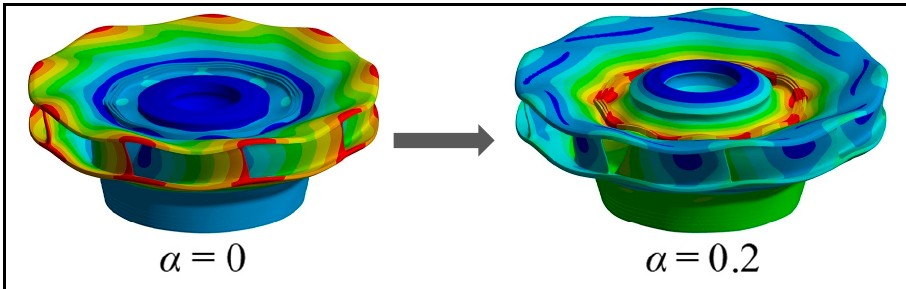
Figure 7. Variation of the 1NC mode with absorption coefficients.